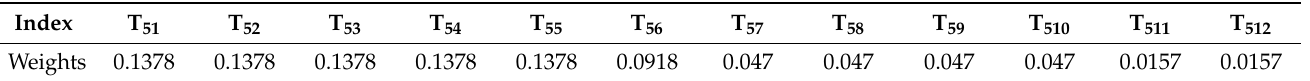
Table 5. Index weight of the appraise layer.